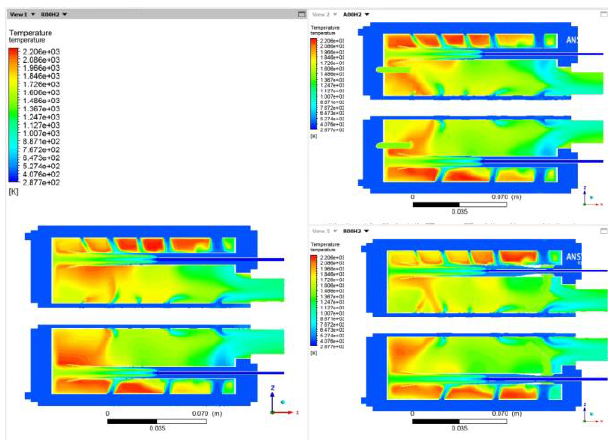
Fig. 9. Combustion static temperature field for pure methane fuelling option